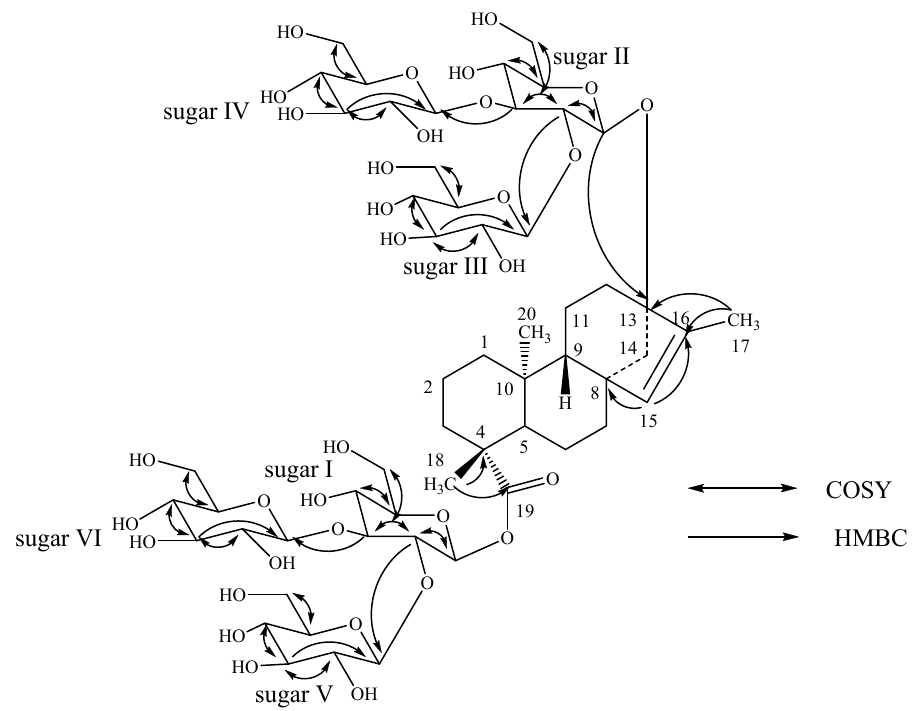
Figure 2. Key COSY and HMBC correlations of 2